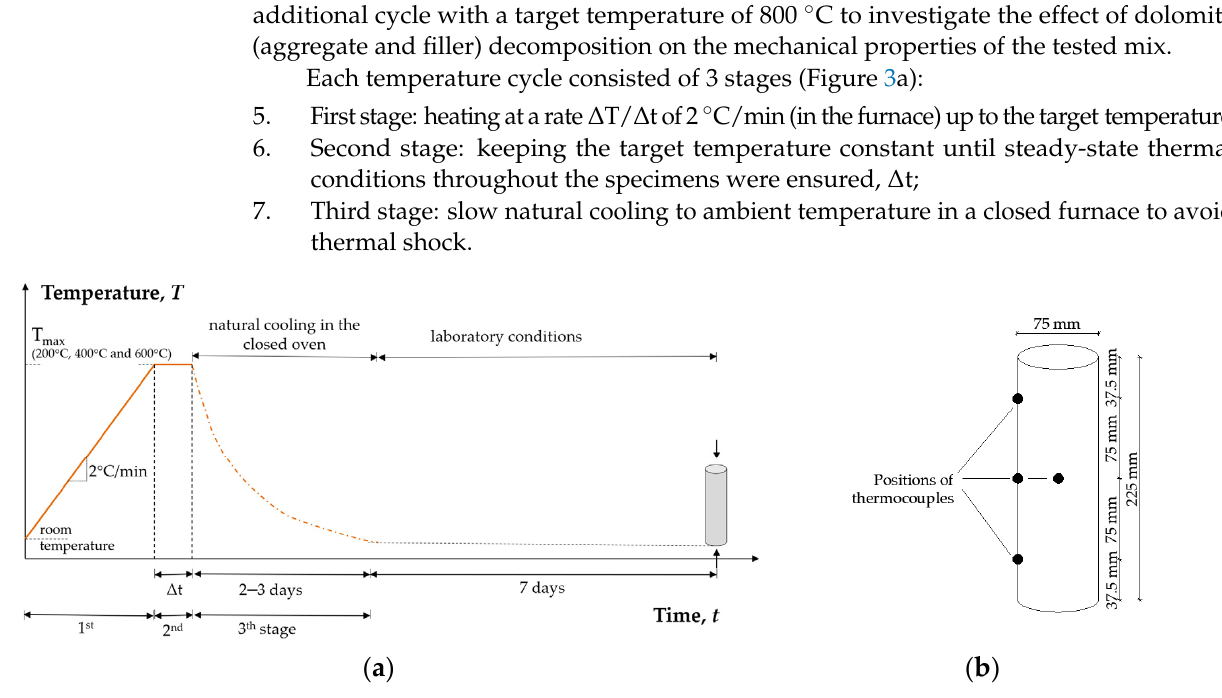
Figure 3. ( a ) Schematic representation of temperature cycle; ( b ) position of NiCr thermocouples in the specimens.